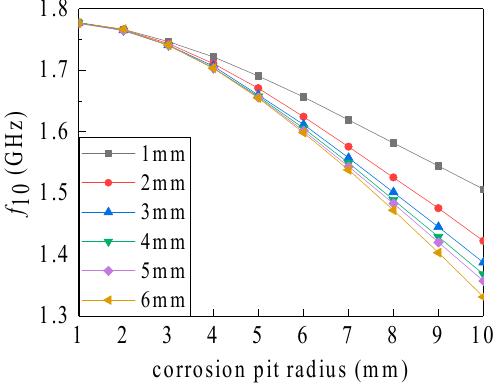
Table 4. Identification sensitivity of the corrosion pit radius.